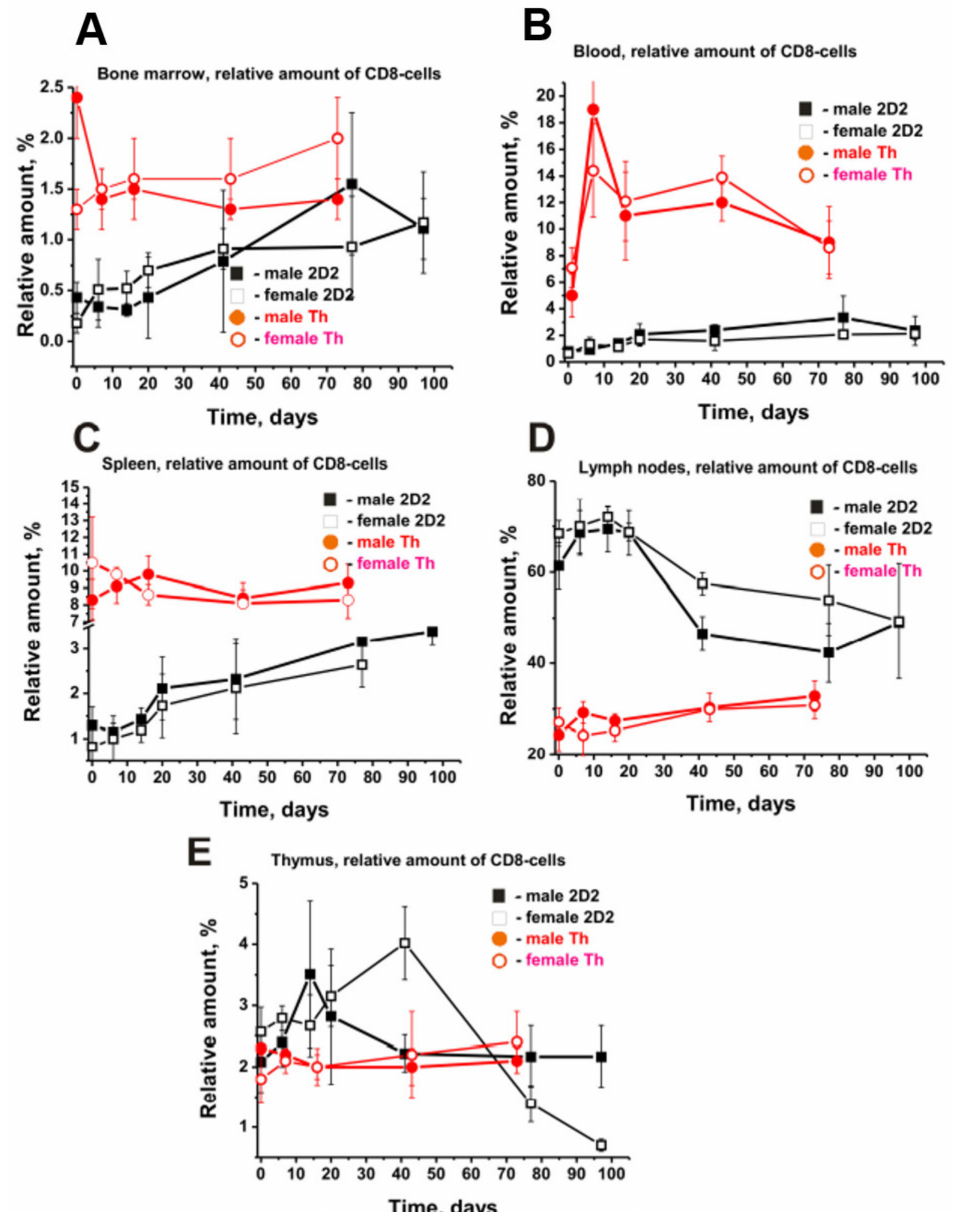
Figure 6. Time-related dependencies in the relative numbers of total CD8 cells in different organs of male and female 2D2 (black symbols) and Th (red symbols) mice. All dependencies for all organs of different males and females are marked in the Figure ( A – E ). For comparison, the data for Th mice were taken from our previously published articles [38,39]. The duration of the experiment and the time of blood sampling for different strains of mice were